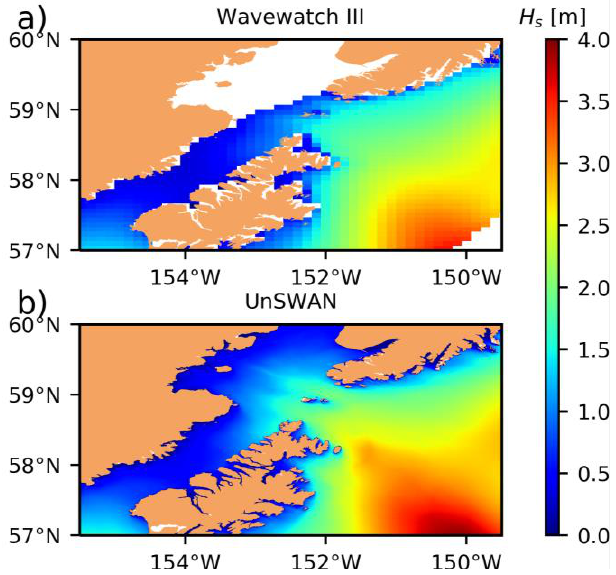
Fig. 6. Significant wave height near Kodiak, Alaska, simulated by Wave Watch III (a) and UnSWAN